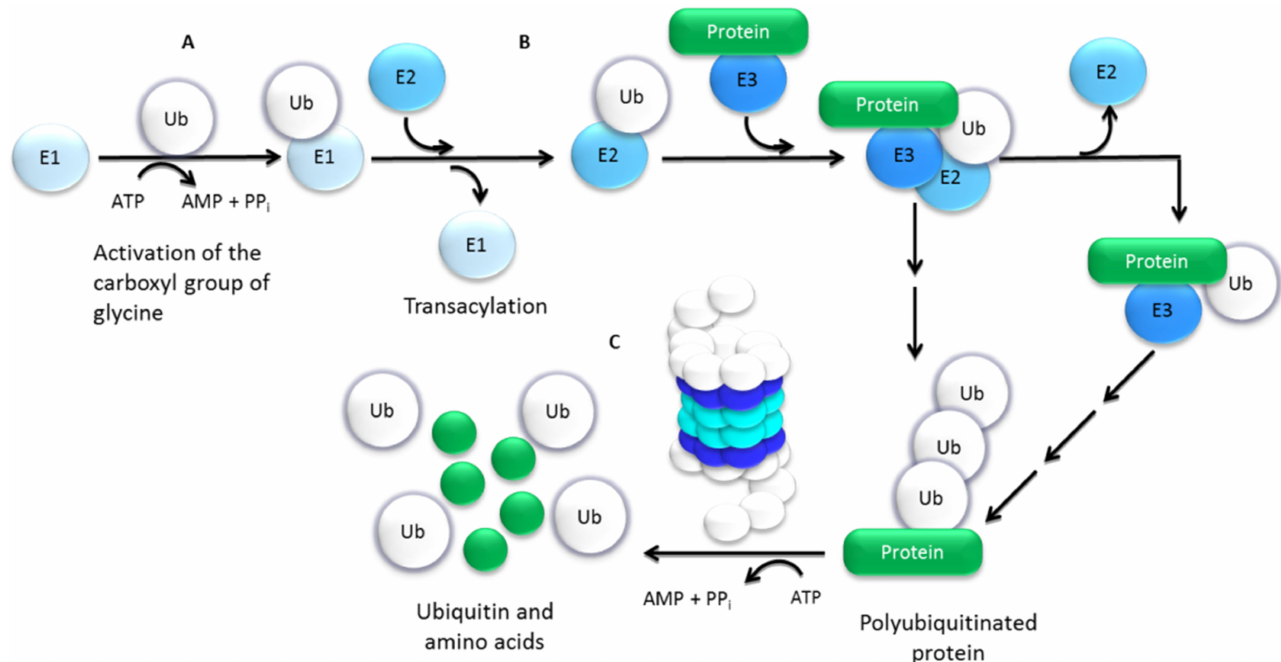
Figure 3. ( A ) Ubiquitin–proteasome pathway of protein degradation. In the ubiquitination process, there is activation of the carboxyl group of glycine found at the C-terminal residues of ubiquitin (Ub), catalyzed by E1 (formation of a thiol-ester bond between E1 and ubiquitin), with the hydrolysis of ATP to AMP and with the release of one PPi molecule. ( B ) After activated ubiquitin is transferred, by transacylation, to the thiol group of the enzyme E2. Then E3 recognizes the protein to be degraded and facilitates E2 to transfer the ubiquitin to the protein, with the formation of an isopeptide covalent bond between the C-terminal glycine residues of ubiquitin and a lysine residue of the protein. ( C ) From multiple cycles of ubiquitination, a polyubiquitinated protein is obtained. In the degradation process, the polyubiquitinated proteins are unfolded and recognized by the 26S proteasome, with ATP hydrolysis to